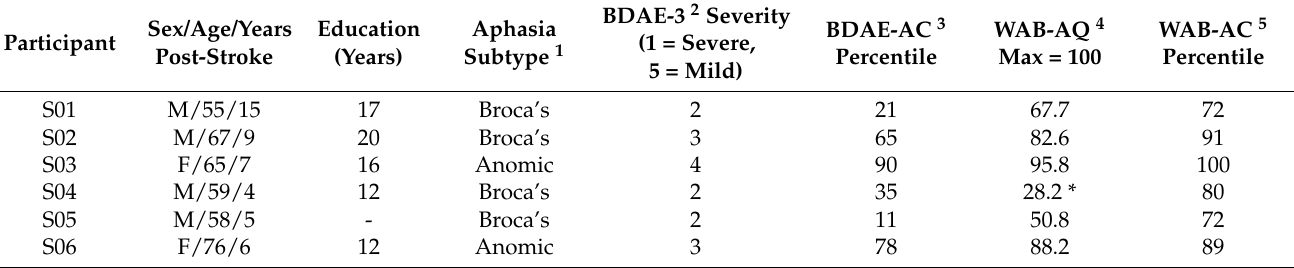
Table 1. Demographic information and language assessment